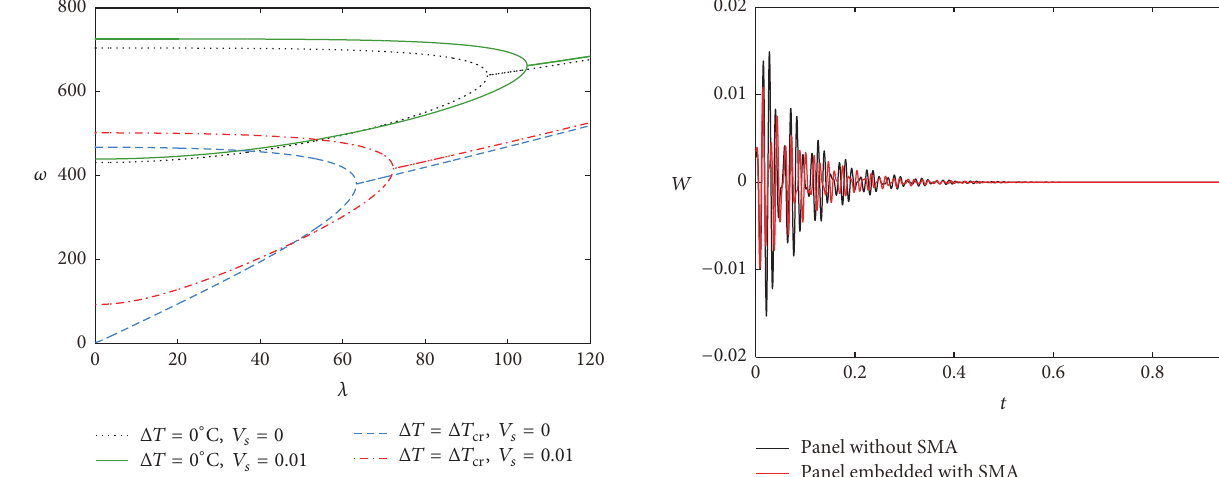
Figure 10: Time history for 𝜆 = 70 and Δ𝑇 = 0.5Δ𝑇 cr .